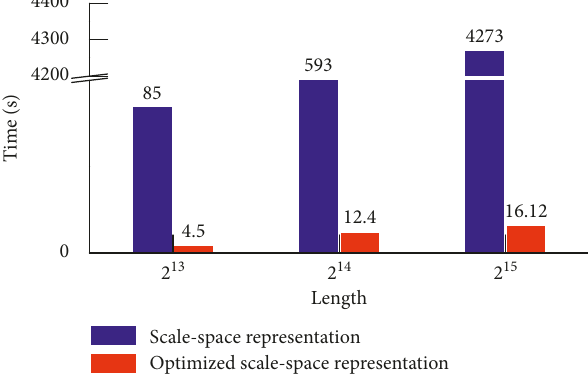
Figure 7: A comparison of the calculation